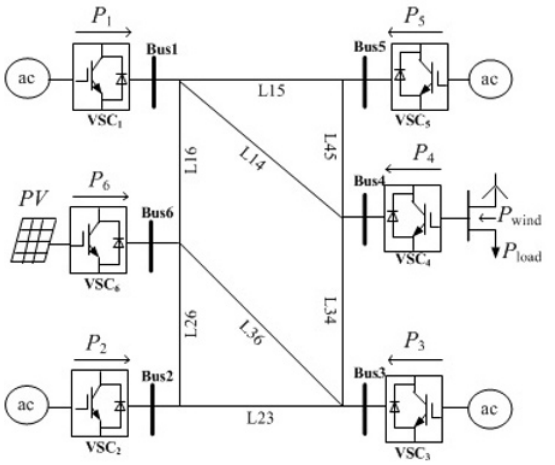
Figure 1. A multi-terminal VSC-HVDC